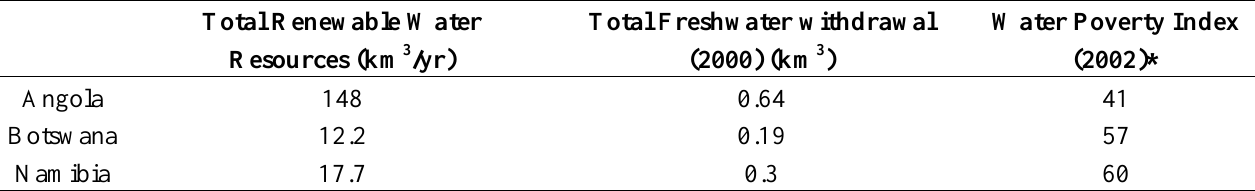
Table 4. Water resources, withdrawal and water poverty in Angola, Botswana and Namibia